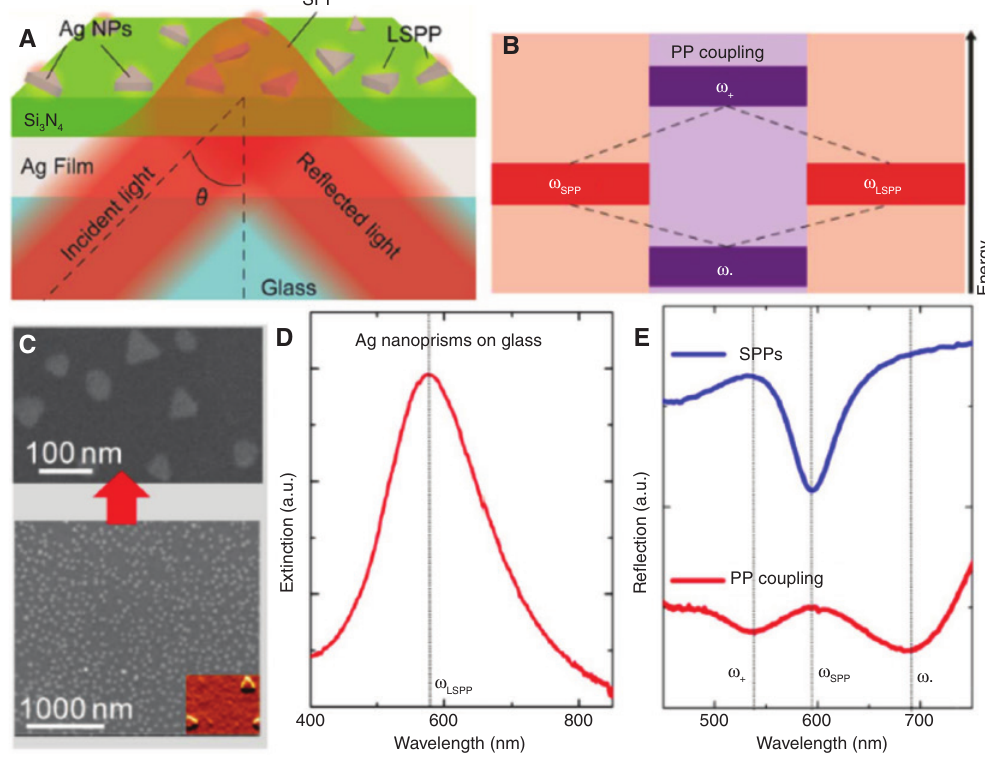
Figure 15: ESP-LSP coupling in prism configuration and Rabi-splitting. (A) Schematic representation of the experimental setup used to measure reflections in the Kretschmann configuration. Reflection measurements are made over 40 ° –50 ° with ~ 0.2 ° angle increments. (B) Schematic representation of the ESP-LSP coupling. (C) SEM images of uniformly coated Ag NPs on 3-aminopropyltriethoxysilane (APTES) modified silicon substrate. The inset indicates an AFM image of the Ag NPs. (D) Extinction spectrum of Ag NPs. (E) Reflection spectra obtained from a bare Ag thin film and Ag NP-coated Ag film at around 45 ° incidence angle. The upper and lower polariton bands are at ~ 525 and ~ 650 nm, respectively. Figure and caption reproduced with permission from